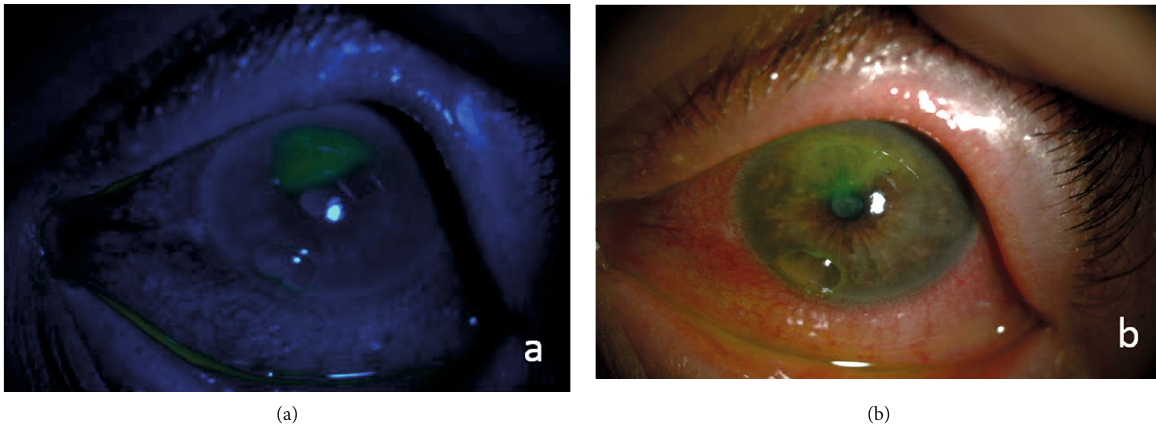
Figure 5: Slit-lamp image of the left eye with conjunctival hyperemia, nonin fi ltrated upper nasal de-epithelization, and inferior nasal bulla.